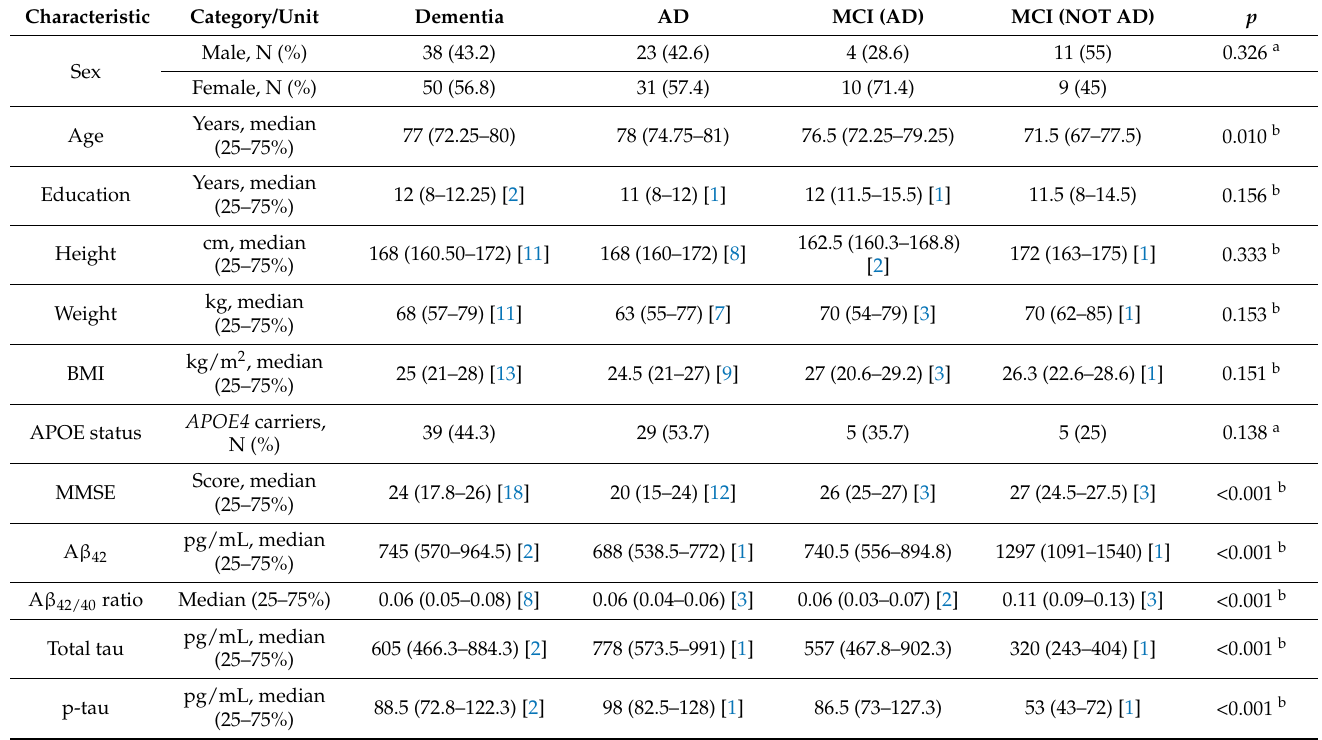
Table 1. Clinical characteristics of all patients with dementia ( N = 88) and of patients with AD ( N = 54), MCI (AD) ( N = 14) and MCI (NOT AD) diagnosis ( N =